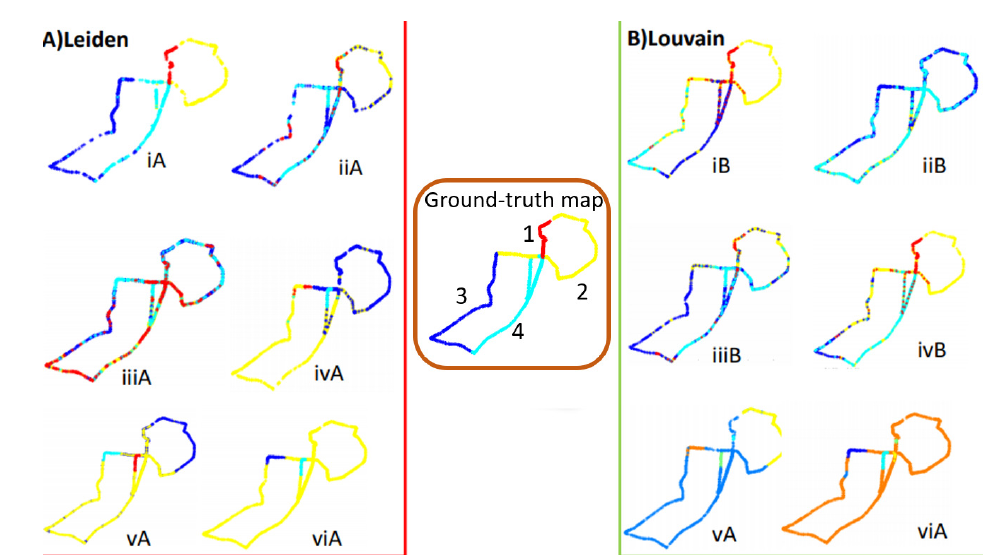
Figure 4. Mapping results produced for different community detection setups, as compared to the ground-truth. Cases (i), (ii) and (iii) arise from the implementation of graph-inspired descriptors, with (i) being produced through the L 2-score, (ii) through the SAD-based similarity and (iii) through the Jaccard index. The semantic maps visualised in (ivA, ivB), (vA, vB) and (viA, viB) are extracted via SURF, SIFT and ORB descriptors,